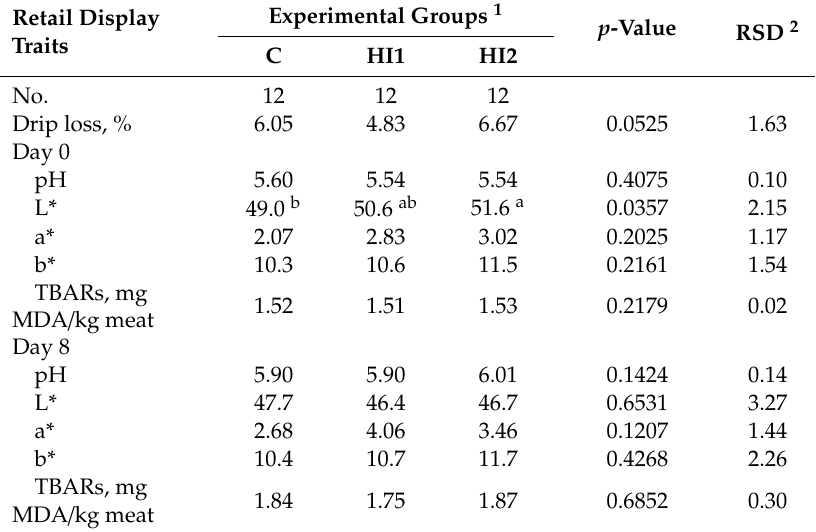
Table 8. E ff ect of the dietary inclusion of Hermetia illucens dried larvae farmed on di ff erent